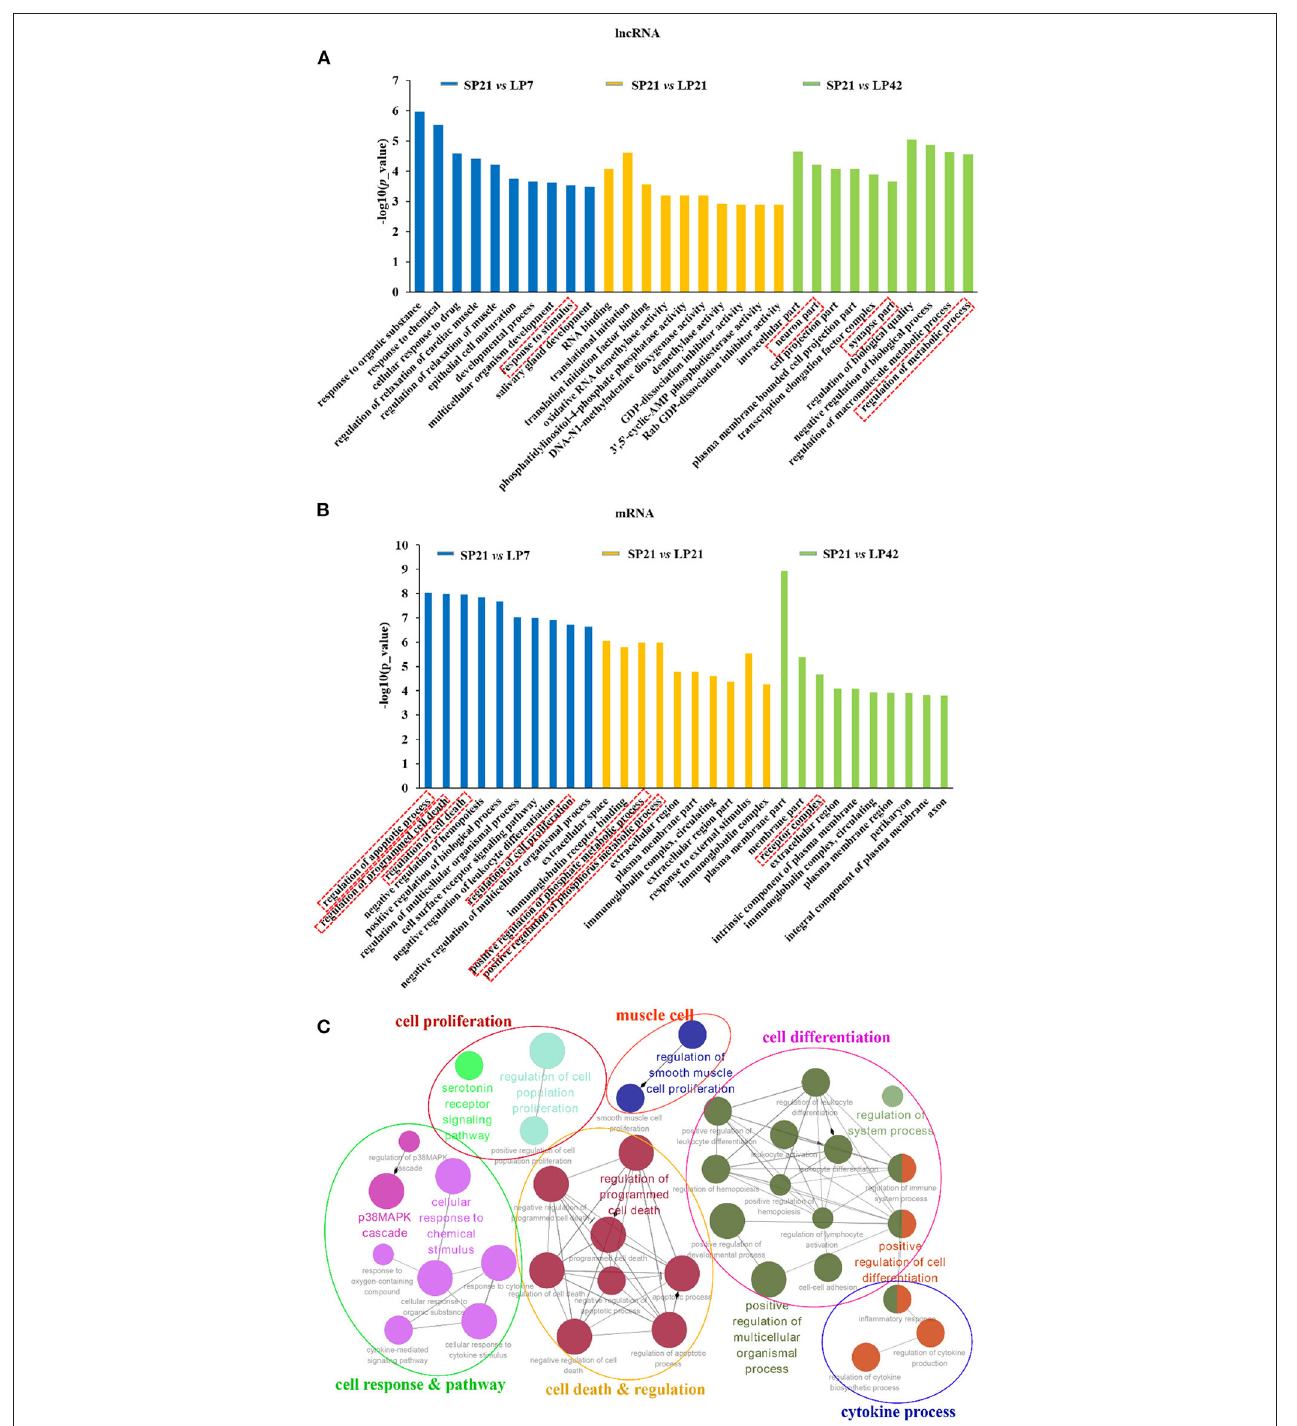
FIGURE 4 | Top enriched Gene Ontology (GO) terms of differentially expressed lncRNAs and genes between short photoperiod and long photoperiod in PT of Sunite sheep. (A) The top GO terms of target genes of differentially expressed LncRNAs; (B) the top GO terms of differentially expressed mRNAs. The GO terms in blue are from SP21 vs. LP7; those in orange are from SP21 vs. LP21, and those in green are from SP21 vs. LP42. (C) A simplified network of related statistically significant GO terms ( p < 0.01) using the Cytoscape add-on ClueGO (34, 35). The network of overlap DE genes among SP21 vs. LP7, LP21, and LP42 are shown. The filled colored circles (nodes) represent each statistically significant parent GO term. The lines (edges) between the nodes show that there are overlapping genes within each term. The colored ovals group these parent GO terms into more generic functional descriptions. The red boxes represent the seasonal reproduction-related terms.